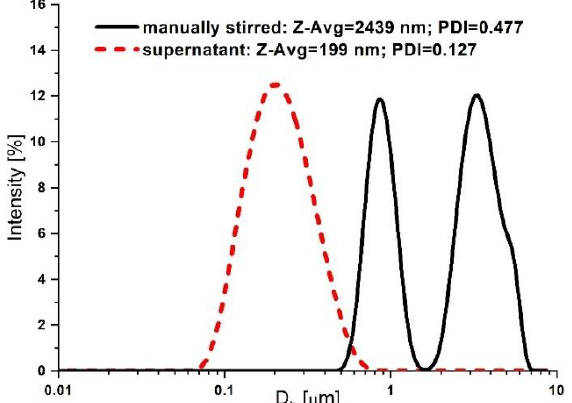
Figure 13. DLS size distribution by the intensity of the manually stirred PEG_MNC sample and the supernatant.